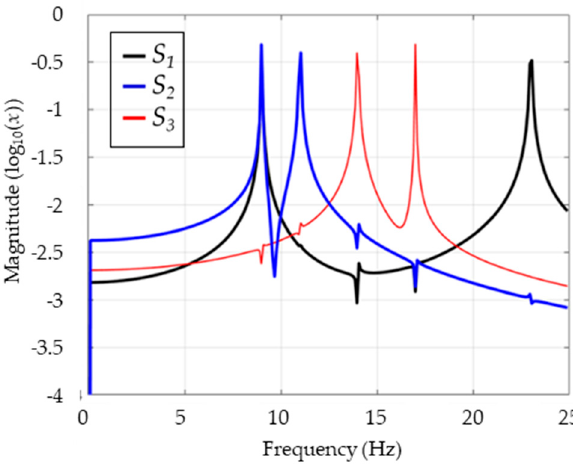
, ( b ) γ 2 , ( c ) γ 2 . 1 y 2 y · 1 3 y · 12